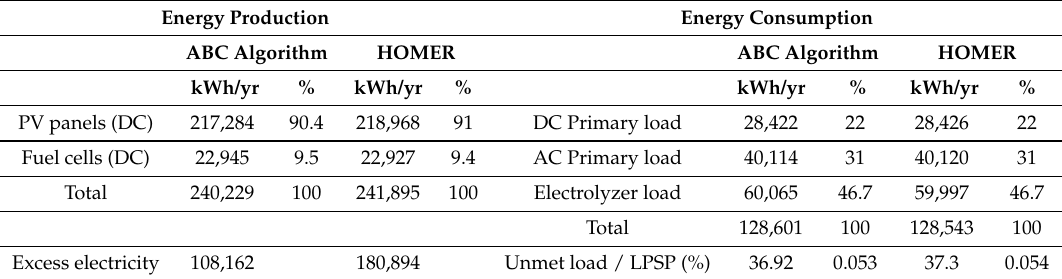
Table 4. Electricity production and consumption for a complete